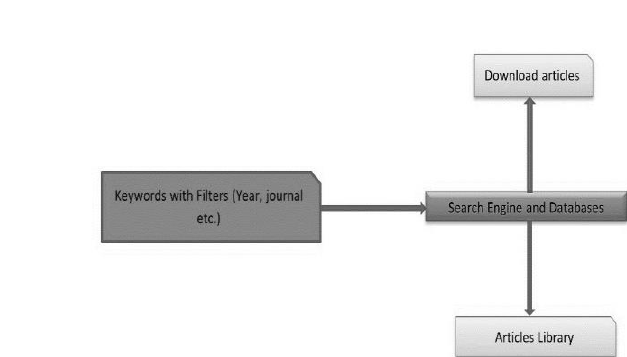
Figure 2. Methodology of literature collection and search